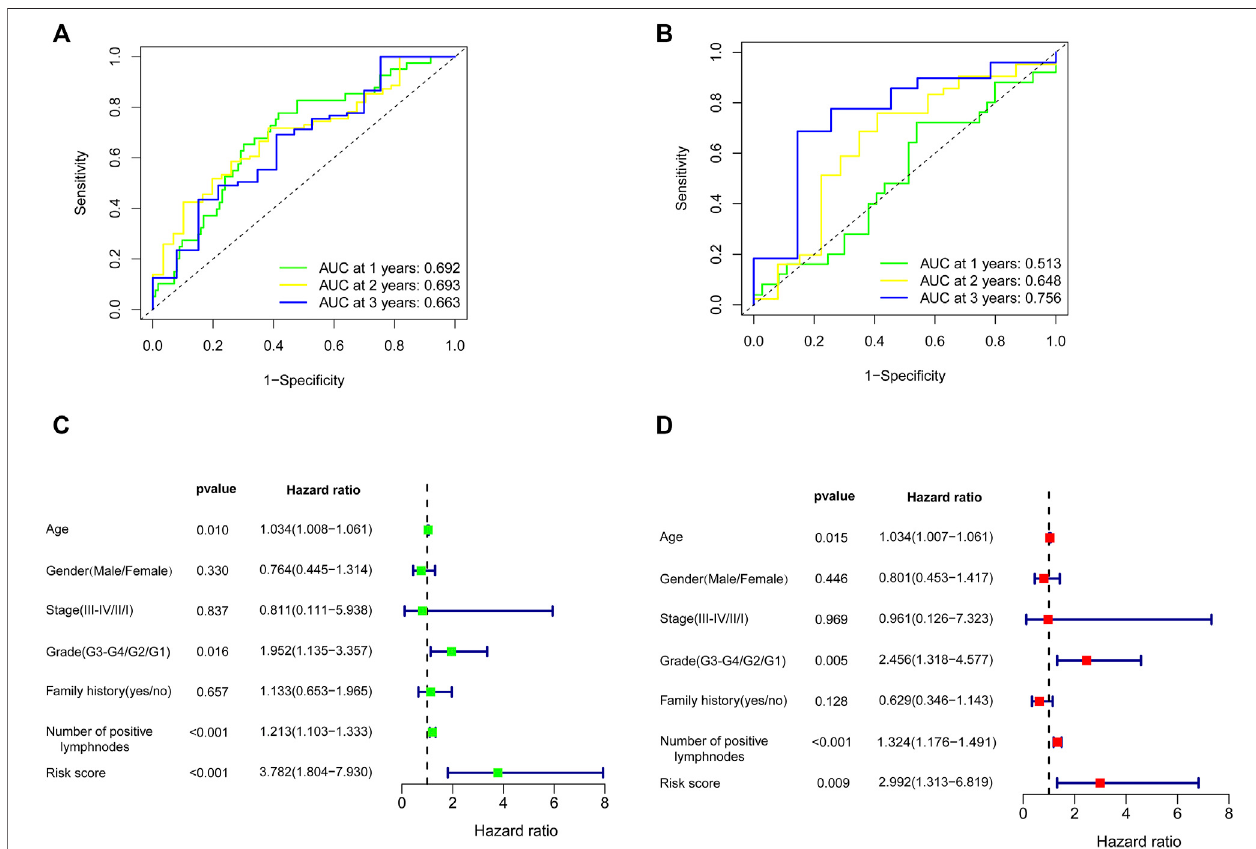
FIGURE7| EffectsoftheriskscoremodelandclinicalparametersontheprognosisofPCpatients.Thetime-dependentROCcurveforpredictingthe1-,2-,and3- yearOSratesinTCGAtrainingcohort (A) andGEOvalidationcohort (B) .Identi fi cationoftheparametersrelatedtoOSbyunivariate (C) andmultivariateCoxanalyses (D) . PC, pancreatic cancer; ROC, receiver operating characteristic; OS, overall survival; TCGA, The Cancer Genome Atlas; GEO, Gene Expression Omnibus.